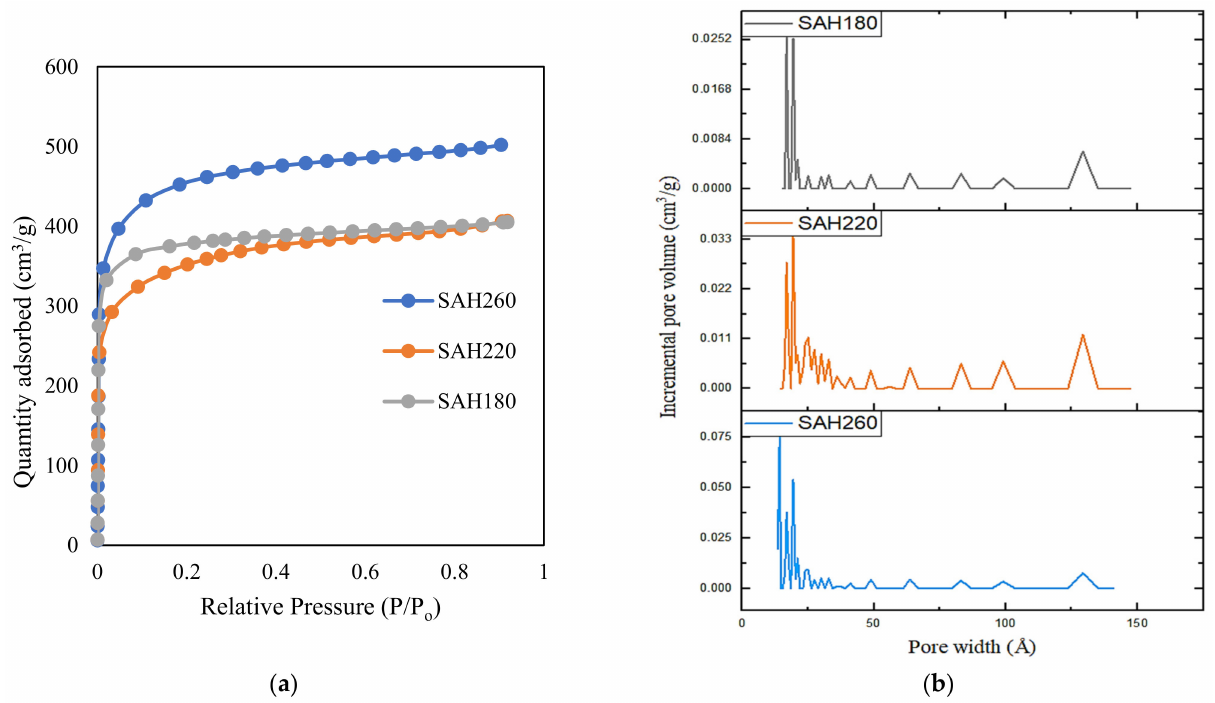
Figure 2. ( a ) Nitrogen adsorption isotherms for superactivated hydrochars SAH180, SAH220, SAH260; ( b ) NLDFT pore size distribution in superactivated hydrochars SAH180, SAH220 and